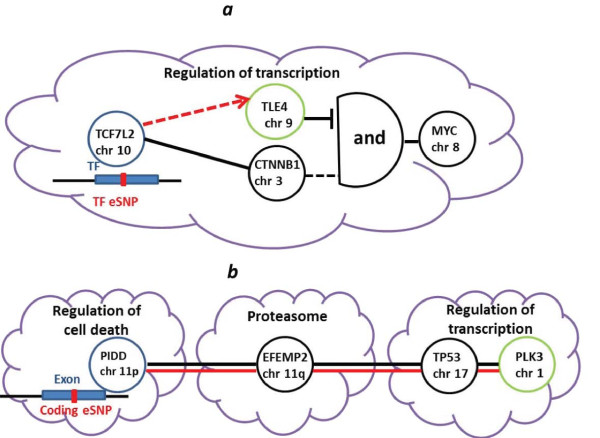
Examples of transcription factors and exon source-target pairs. An eSNP (red tick mark) along a source gene (blue circle), either in an exon or TF (blue rectangle), is associated (solid red line for exon, dashed for TF) with levels of transcription of the target gene (green circle). The source and target genes interact via nodes (black circles) and edges (black solid lines) in the PPI network. Each node belongs to a PPI cluster (purple cloud) with a functional annotation. (a) Network motif I1-FFL [42]: TCF7L2 activates MYC (in the presence of CTNNB1) but also represses MYC by activating the repressor TLE4 (via an eSNP) . (b) The shortest path on the PPI network between PIDD source and its gene target PLK3. Binding sites of TP53 were found in the promoter of PLK3. TP53 is annotated as a zinc ion binding protein. There was a significant correlation between the expression of the source and target genes. TCF7L2, transcription factor 7-like 2; T-cell specific; TLE4 transducin-like enhancer of split 4; MYC, v-myc avian myelocytomatosis viral oncogene; catenin (cadherin-associated protein), beta 1, 88kDa (CTNNB1); PIDD, p53-induced death domain protein; PLK3, polo-like kinase 3; EFEMP2, Epidermal growth factor-containing fibulin-like extracellular matrix protein 2; TP53, tumor protein p53.